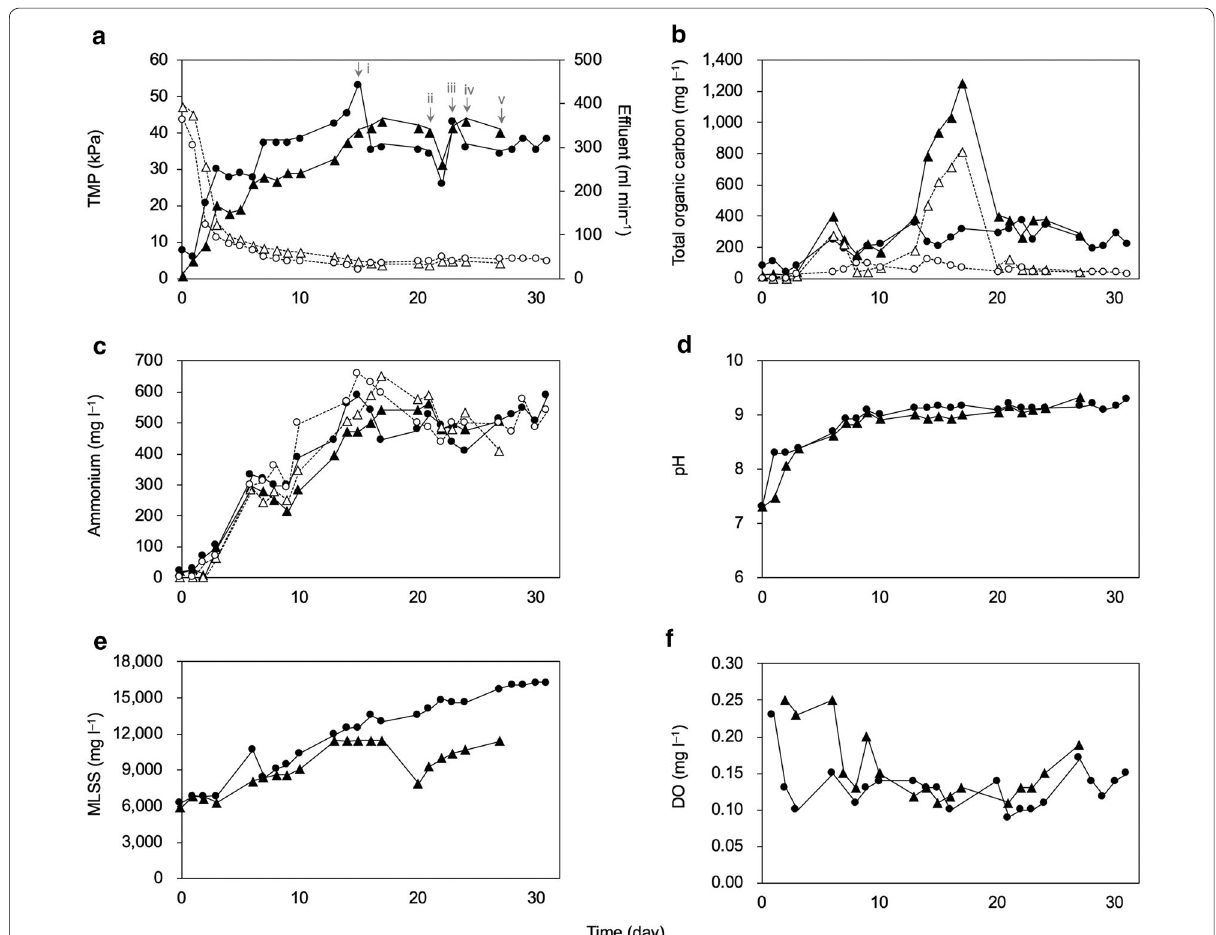
Fig. 1 Physicochemical parameters in the membrane bioreactors. a Transmembrane pressure (TMP) and effluent flow rate; b total organic carbon (TOC) concentration; c ammonium concentration; d pH; e mixed liquor suspended solids (MLSS) concentration; f dissolved oxygen concentration. Circles and triangles denote the data for Reactors 1 and 2, respectively, and closed and open symbols denote the data detected in the sludge and effluent, respectively. The arrows in panel A indicate the day of membrane cleaning with 0.1% NaOCl; (i) Cleaning was performed on Day 15 in Reactor 1 and on Days 21, 23, and 24 (ii, iii and iv) in both